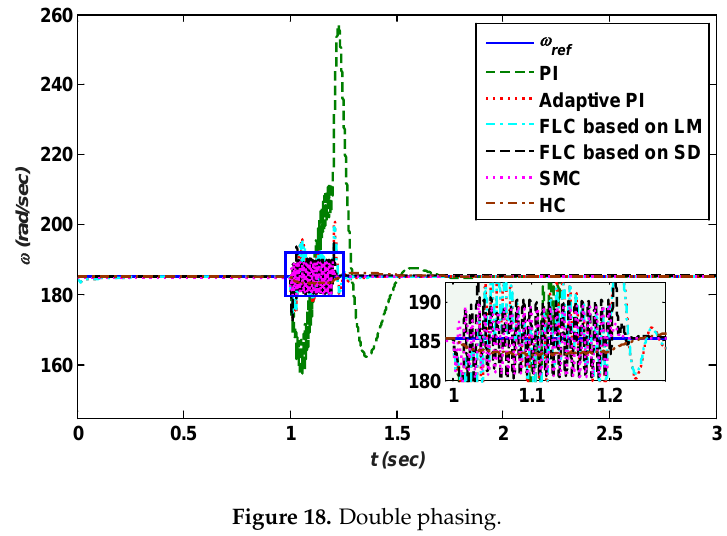
Figure 18. Double phasing.